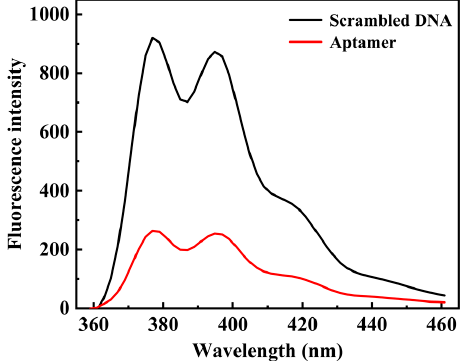
Figure 3. Fluorescence emission spectra in addition to pyrene-labeled scrambled DNA sequence and N protein aptamer. The concentration of β -CDP was 1.5 mg/mL. The concentration of N protein was 600 nM. The concentration of pyrene-labeled aptamer or pyrene-labeled scrambled DNA sequence was set at 400 nM. The maximum emission wavelength was set at 376 nm.